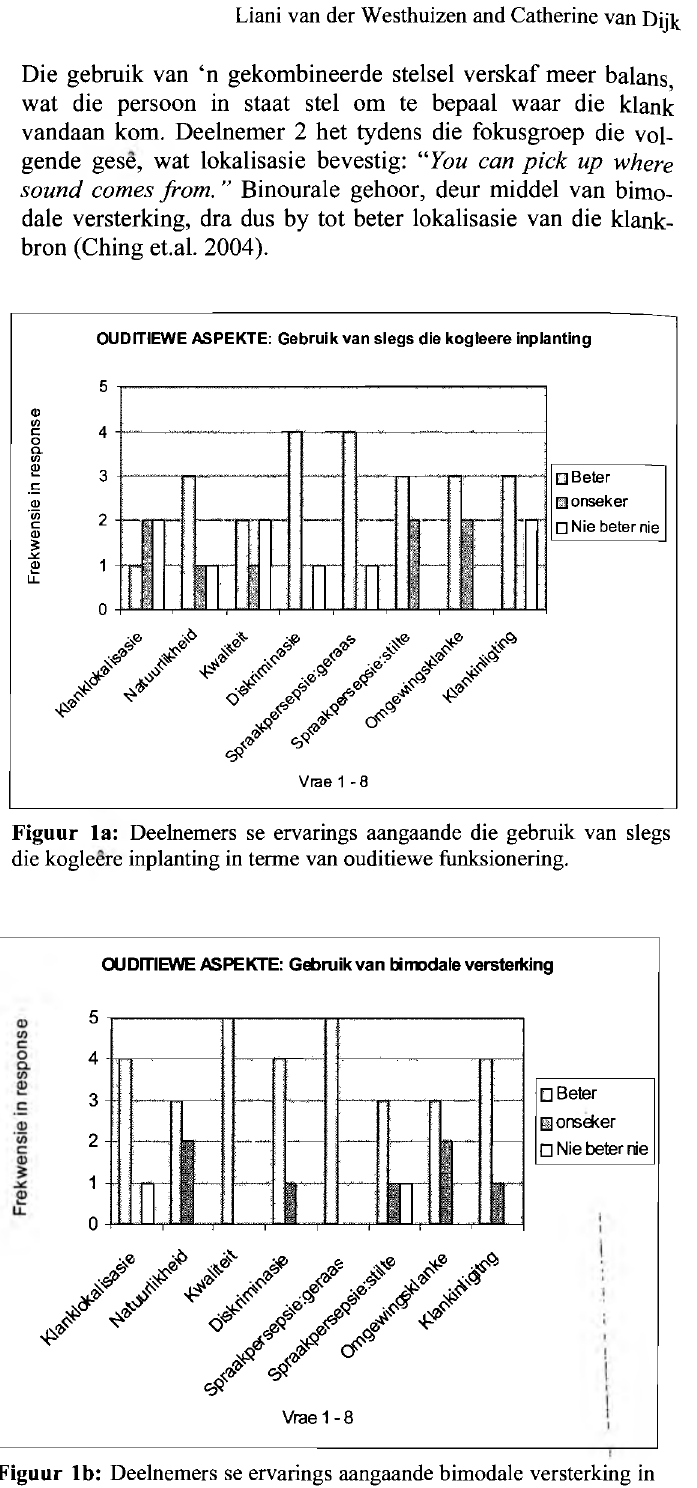
Figuur lb: Deelnemers se ervarings aangaande bimodale versterking in terme van ouditiewe fiinksionering.